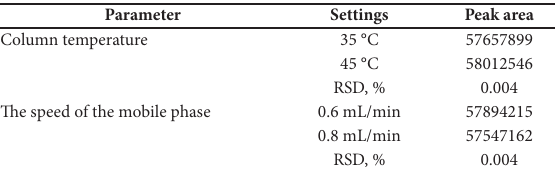
Table 9. The results of the in-laboratory precision test. №